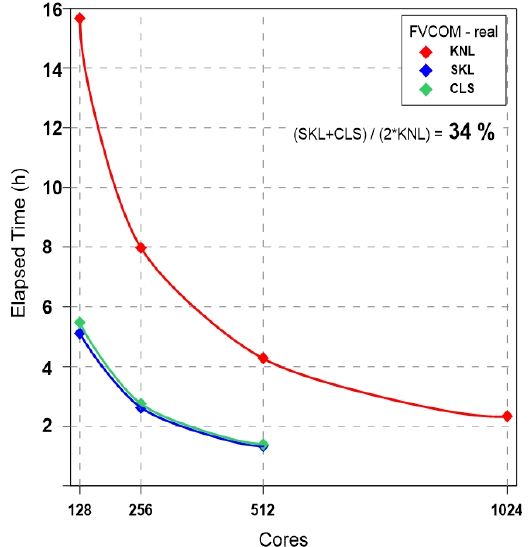
Figure 19. Performances of FVCOM-NWP with respect to the number of cores for the real experiment: (SKL+CLS)/(2*KNL) = 34%.